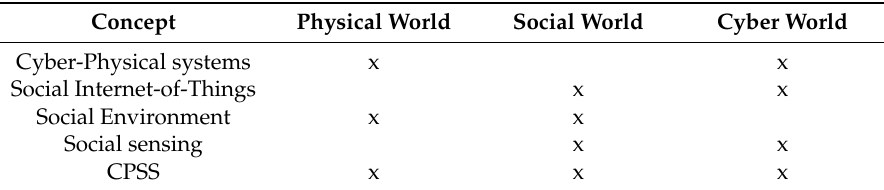
Table 1. Different concepts about the relations among the CPSS